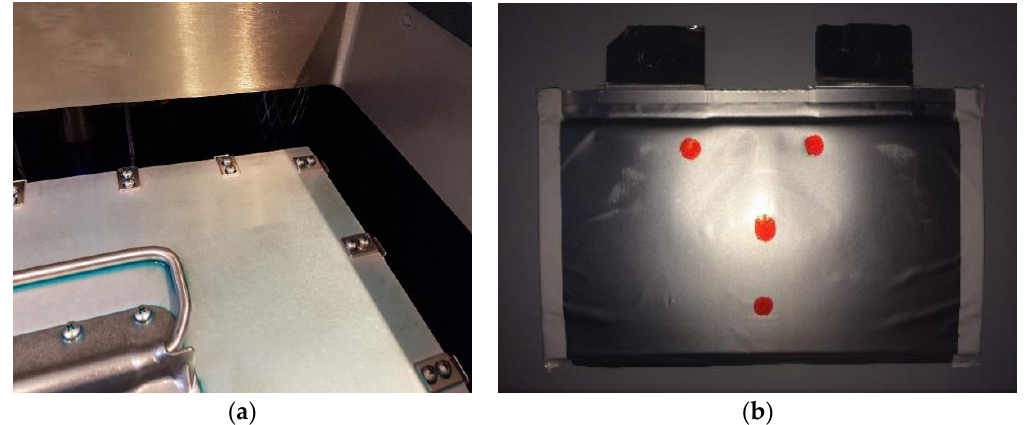
Figure 5. The internal outlook of the calorimeter and battery. ( a ) Calorimeter lid; ( b ) 13 Ah Altairnano lithium titanate oxide battery cell.